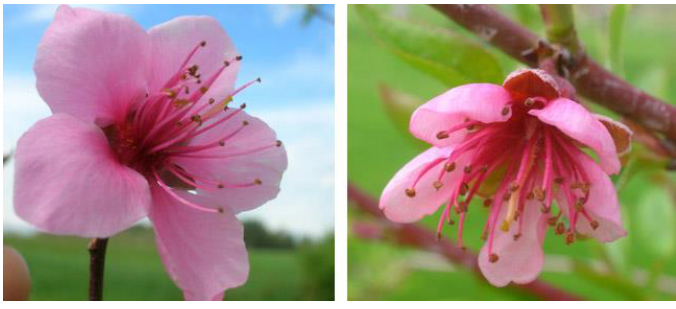
Figure 1. Rose and bell flower of peach Figure 2. Downy fruits